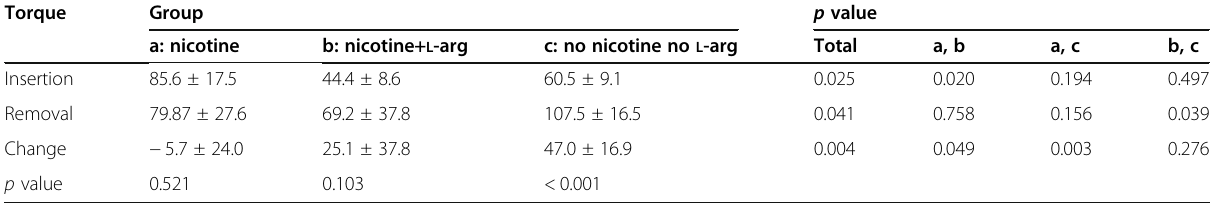
Table 1 Comparison of torque between the 3 groups (pound per inch) Torque